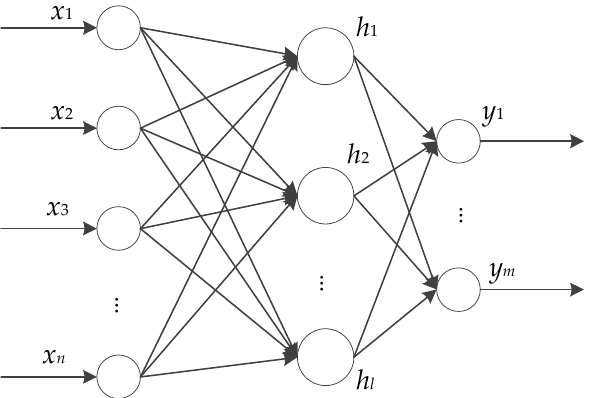
Figure 6. Technical route of establishing dynamic load characteristics prediction model. Note: x = [ x 1 , x 2 , . . . , x n ] represents the input vector; h = [ h 1 , h 2 , . . . , h l ] represents the middle layer; y = [ y 1 , y 2 , . . . , y m ] represents output